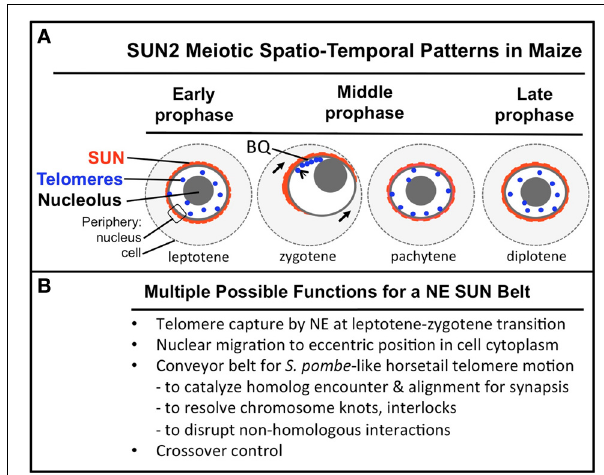
FIGURE 9 | A summary diagram of the meiotic SUN belt spatio-temporal staining patterns and possible functions. A summary diagram (A) shows the relative distribution of SUN2 staining (red), telomeres (blue dots), nucleolus (gray circle), and the peripheries of the NE and cell. Stages of prophase are indicated at the bottom of each cell. The telomere bouquet (BQ) is indicted in zygotene as being localized within the partially retracted or polarized SUN belt signals. (B) Conceivable functions for the maize meiotic SUN belt are